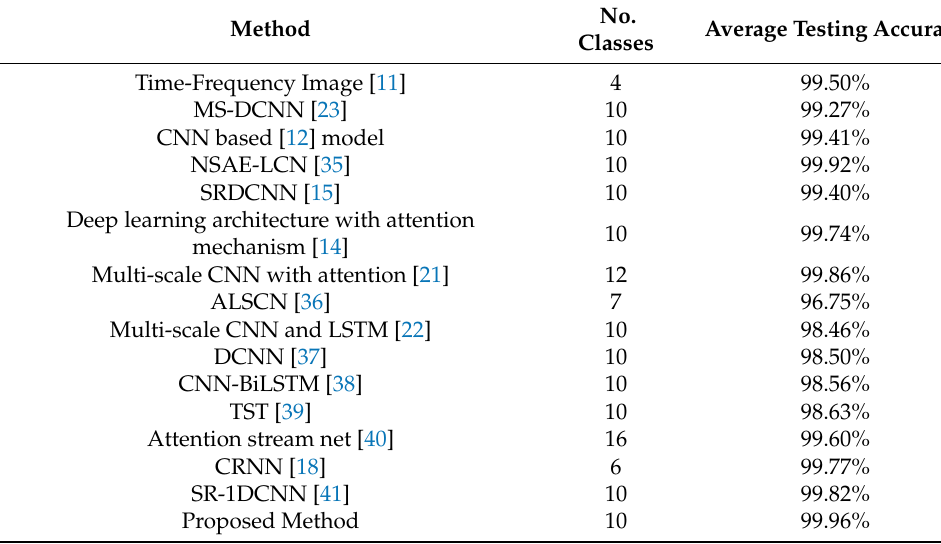
Table 4. Comparison of the proposed scheme with other